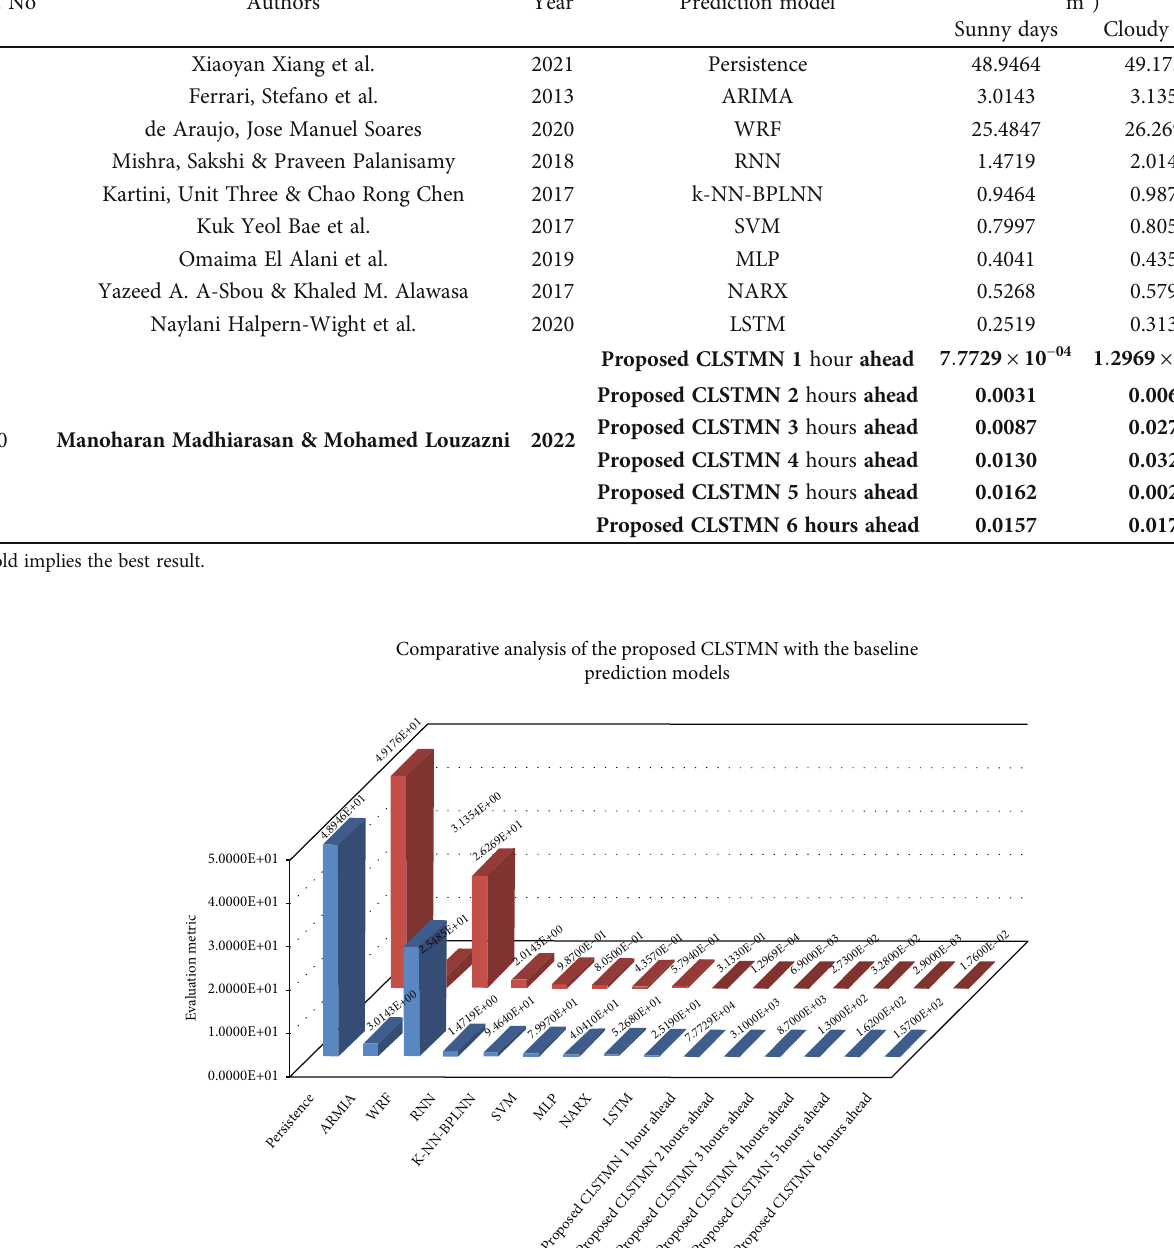
Table 3: Comparative analysis of the proposed CLSTMN with the baseline prediction model on sunny and cloudy datasets. S. No